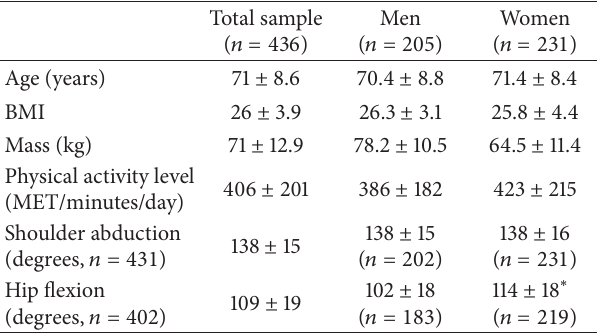
Table 1: Subject